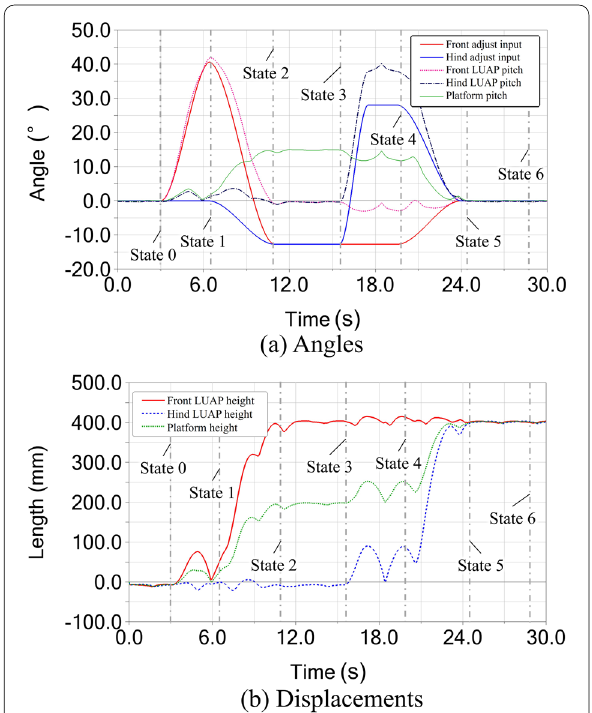
Figure 15 Simulation results of Model